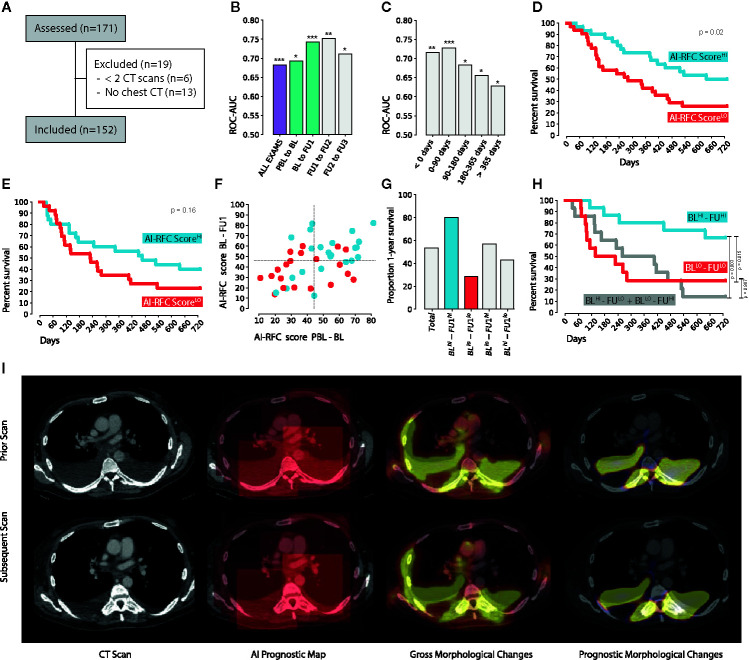

(A) CONSORT diagram. (B) 1-year survival classification performance on the independent validation set, with respect to the clinical follow-up routine (highlighted in green the ROC-AUC of the scan pairs used for the 2-years survival analysis) and (C) corrected by time. (D) 2-years Kaplan-Meier curves of the RFC survival score of BL-FU1 and (E) PBL-BL. (F) Combination of the PBL-BL and BL-FU1 RFC survival scores with (G) enrichment of each of the four quadrants (F, H) survival of each of the four quadrants. (I) Example of the occlusion sensitivity method used for AI explainability and visualization. * indicates p < 0.05, **p < 0.01, ***p < 0.001.